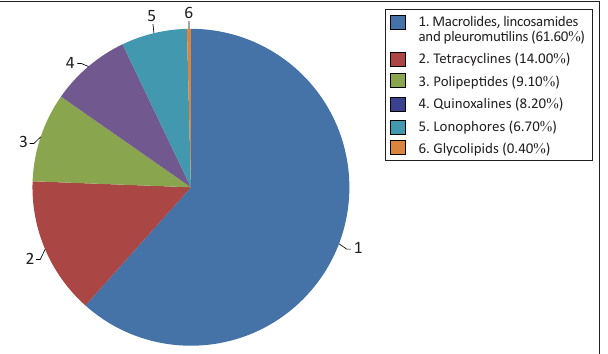
FIGURE 2: Percentages of volume (kg) for sales of in-feed antimicrobials for the period 2002–2004.